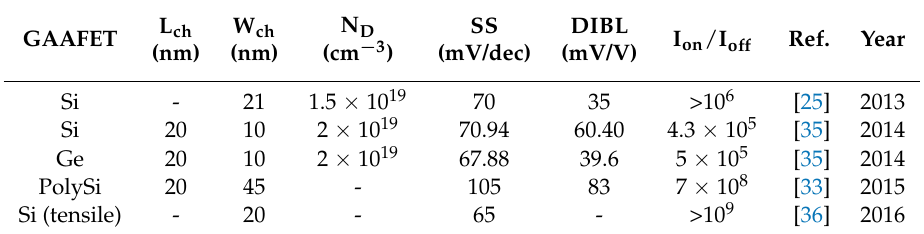
Table 1. Reported figure of merits of junctionless GAAFETs. L ch and W ch are the channel length and width,